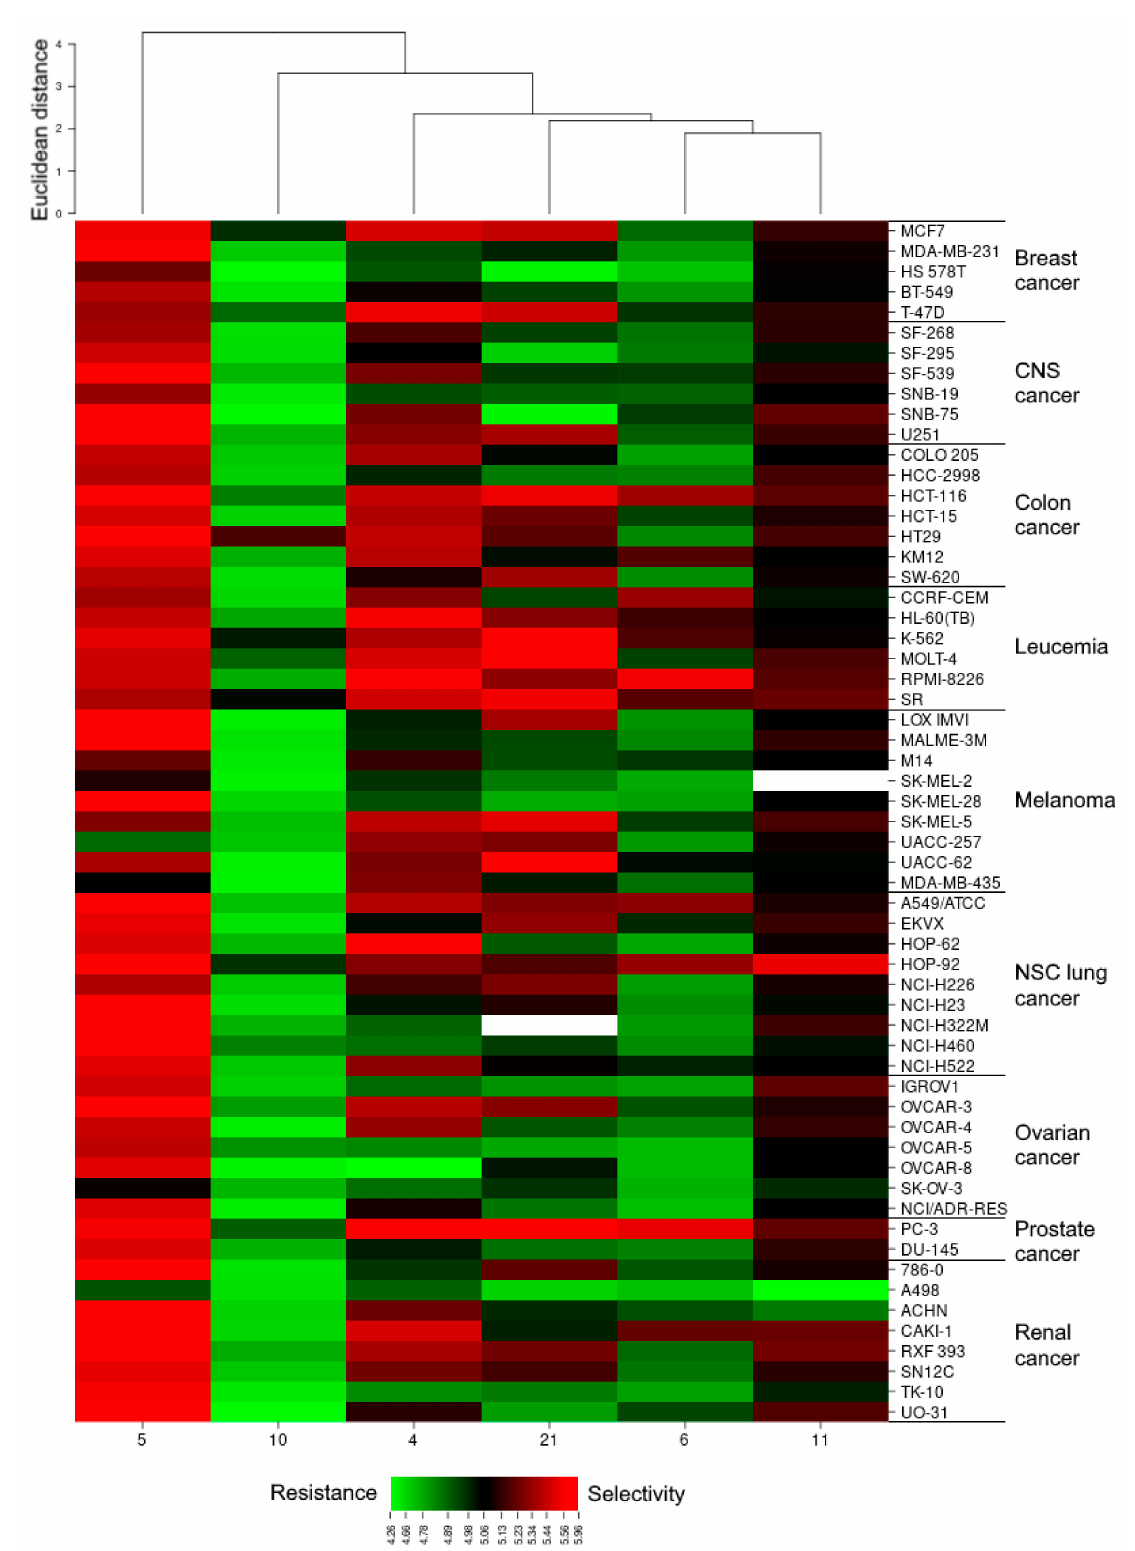
Figure 2. Heatmap for pGI 50 values of compounds 4 – 6 , 10 , 11 and 21 obtained in the NCI-60 screen. The color gradient ranges from green (low activity) to red (high activity). White cells indicate the absence of data for the corresponding cell line. The hierarchical clustering of pGI 50 activity patterns was done using the Euclidian distance method and the average linkage cluster